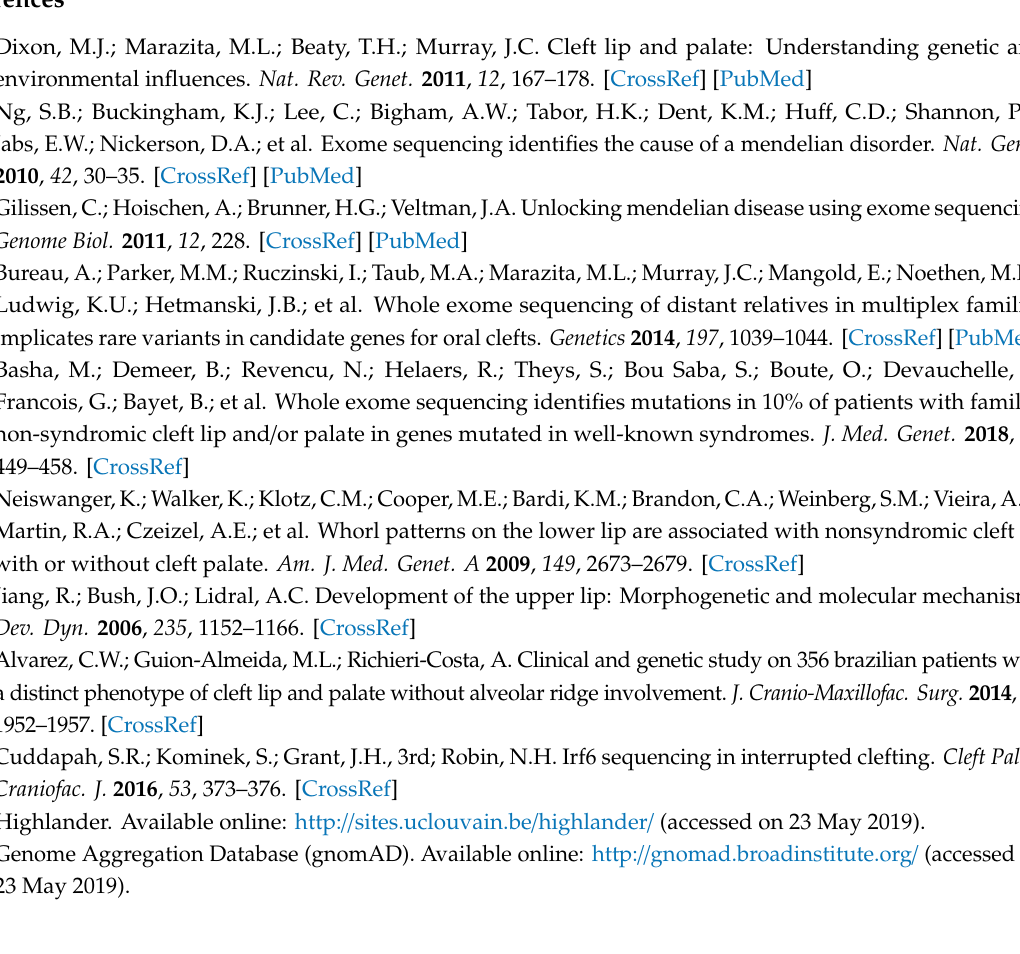
Table S1: List of 89 studied